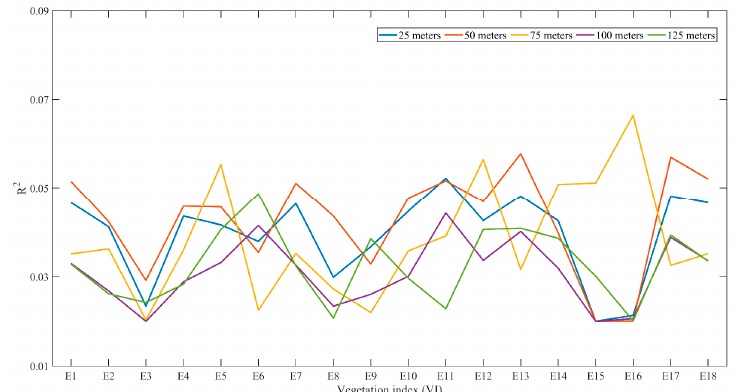
Figure A3. The linear regression results between vegetation index and measured values using SPAD-502.